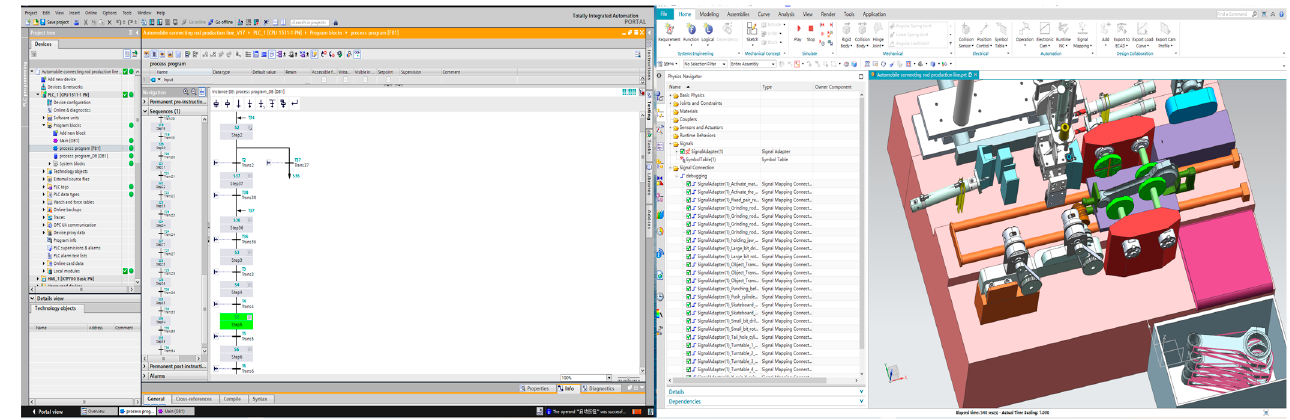
Appl. Sci. 2023 , 13 , x FOR PEER REVIEW Figure 18. Real-time debugging of both ends of rough grinding. Figure 18. Real-time debugging of both ends of rough grinding.